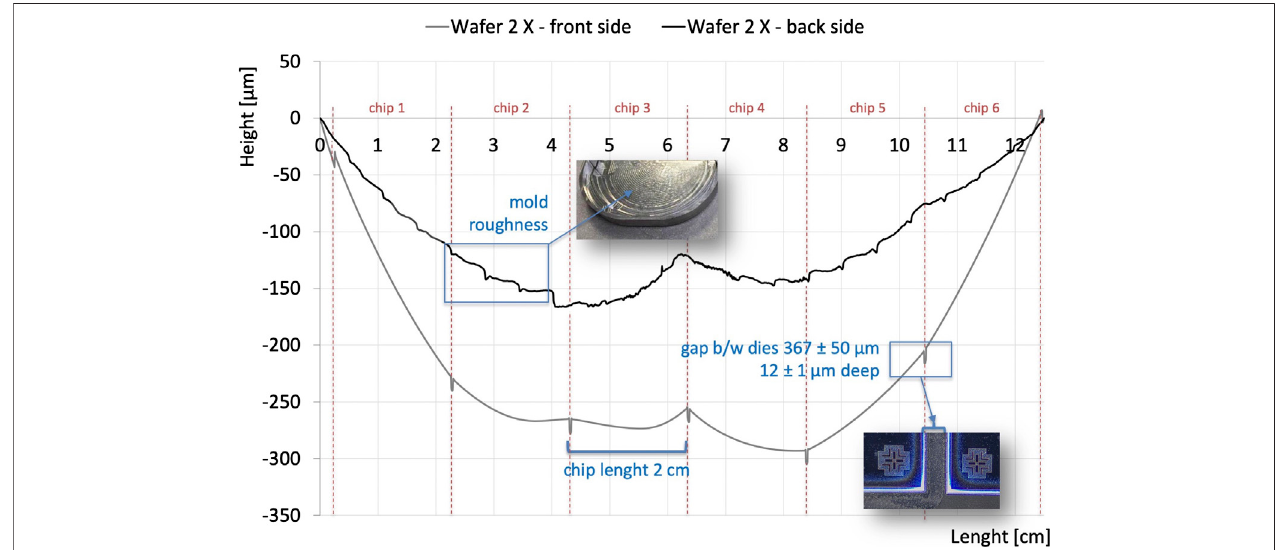
FIGURE 4 | lower (gray) and upper (black) diametrical pro fi le of WLP 2. In the pro fi le of the upper side, the curvatures of the individual chips and the gaps not completely fi lled with resin are visible between one chip and the next. This is due to the protrusion of the bonding fi lm between the chips after the application of the high pressure. The roughness of the mold machining is visible in the pro fi le of the lower side. Between chip number three and four is visible the wrinkle described in the